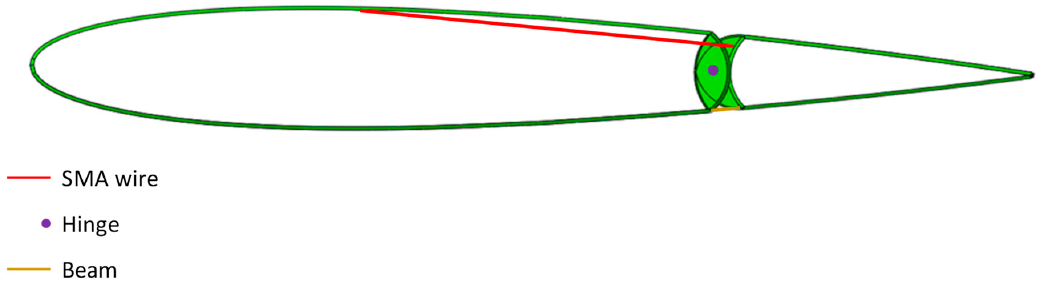
Figure 8. Trailing edge actuation, details of the SMA, hinge, and beam locations.